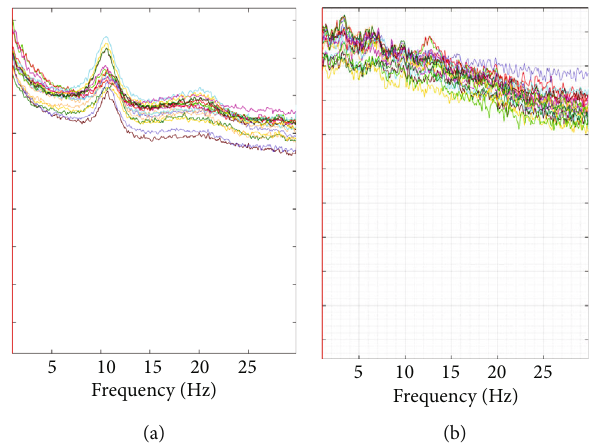
Figure 2: Comparison of power spectrum between DOC group and CG group. (a) Power spectrum of the CG group, higher power can be seen in the alpha band of 10-15 Hz. (b) The power spectrum of the DOC group. It is dominated by high slow wave power. (DOC: disorder of consciousness; CG: control